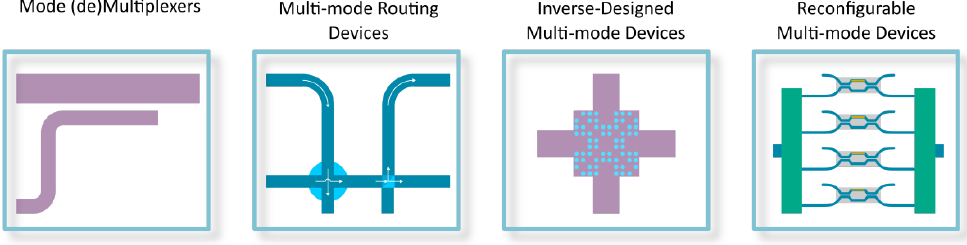
Figure 2. A table of contents: the main topics that will be discussed in the following sections.